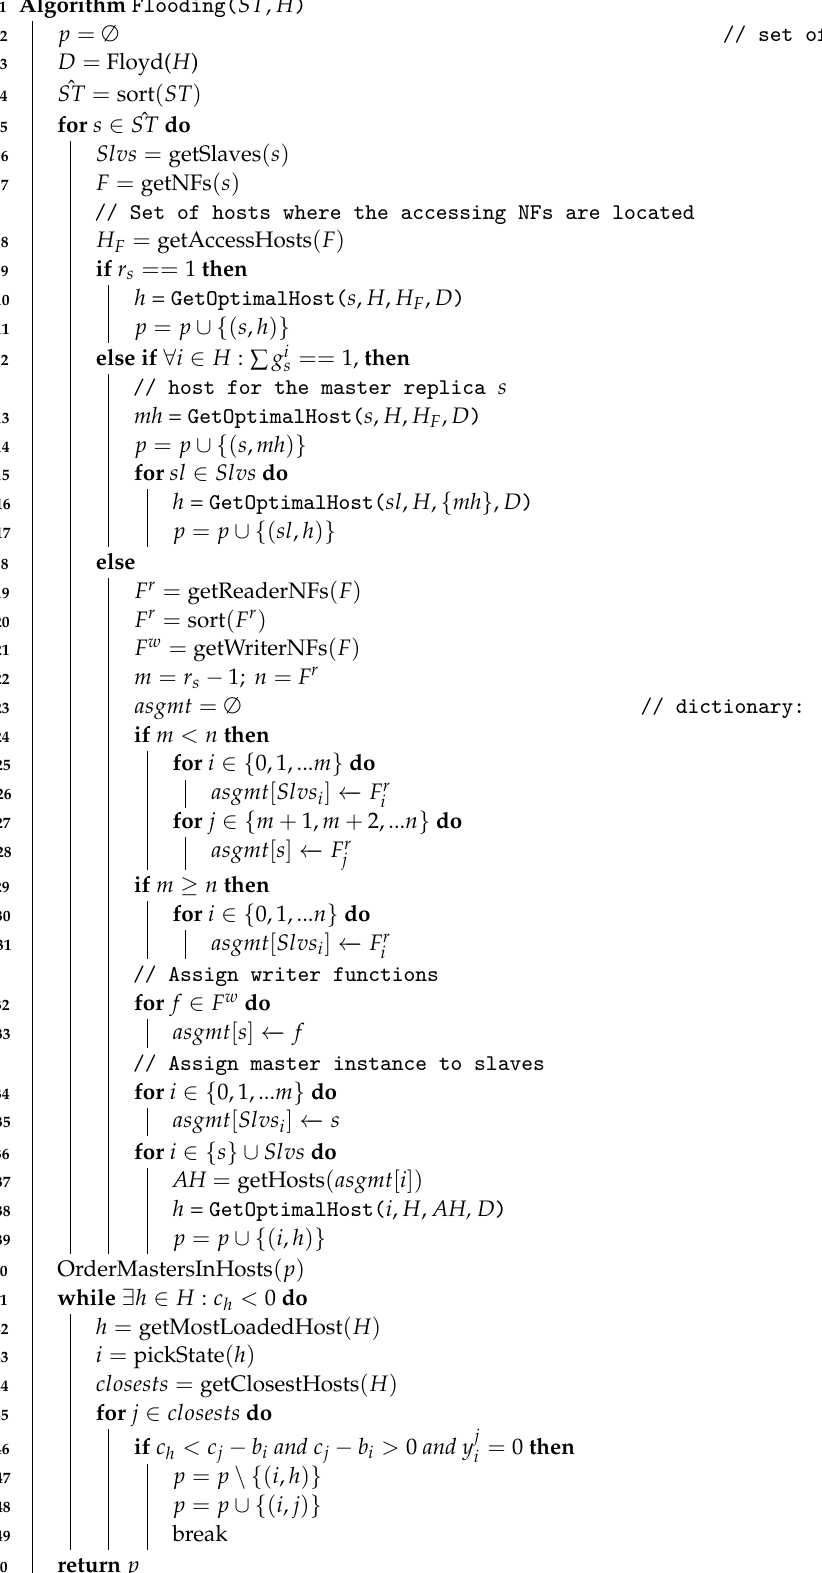
Algorithm 1: Flooding